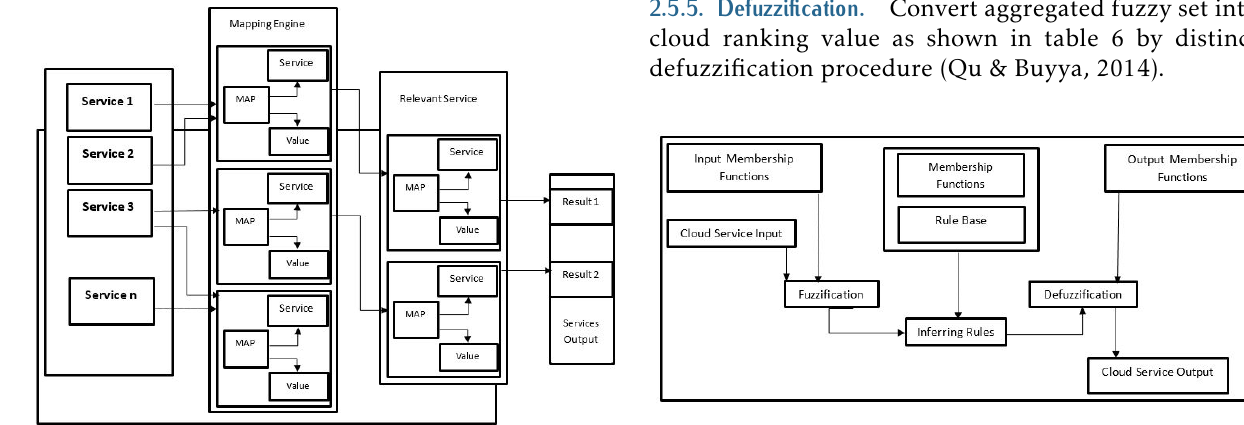
Figure 3. Fuzzy Inference